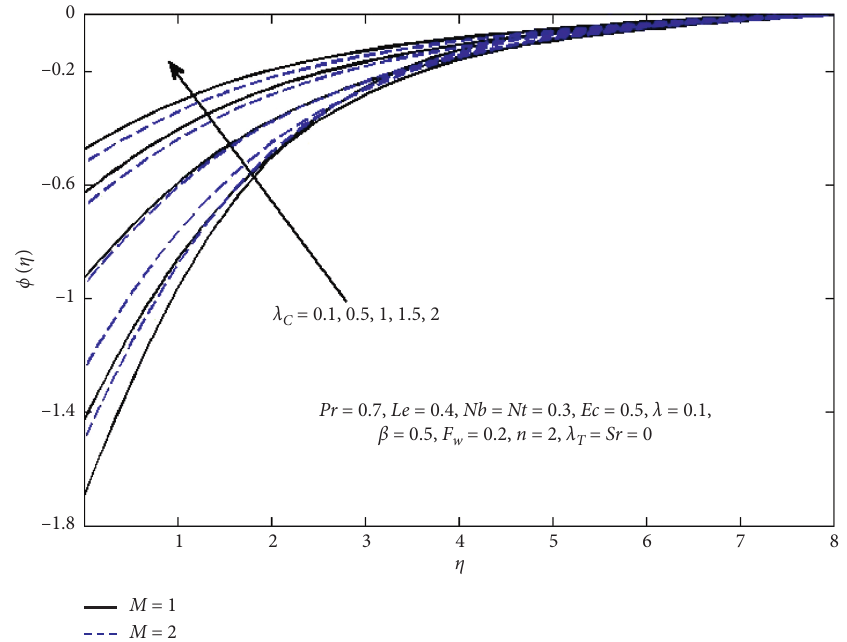
Figure 4: Variation concentration ϕ concerning η with various values of λ